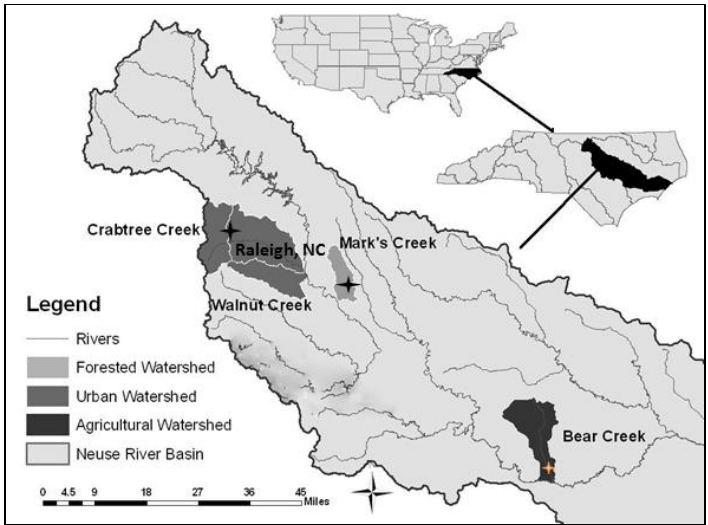
Figure 1. Map of upper Neuse River Basin with study sites marked by